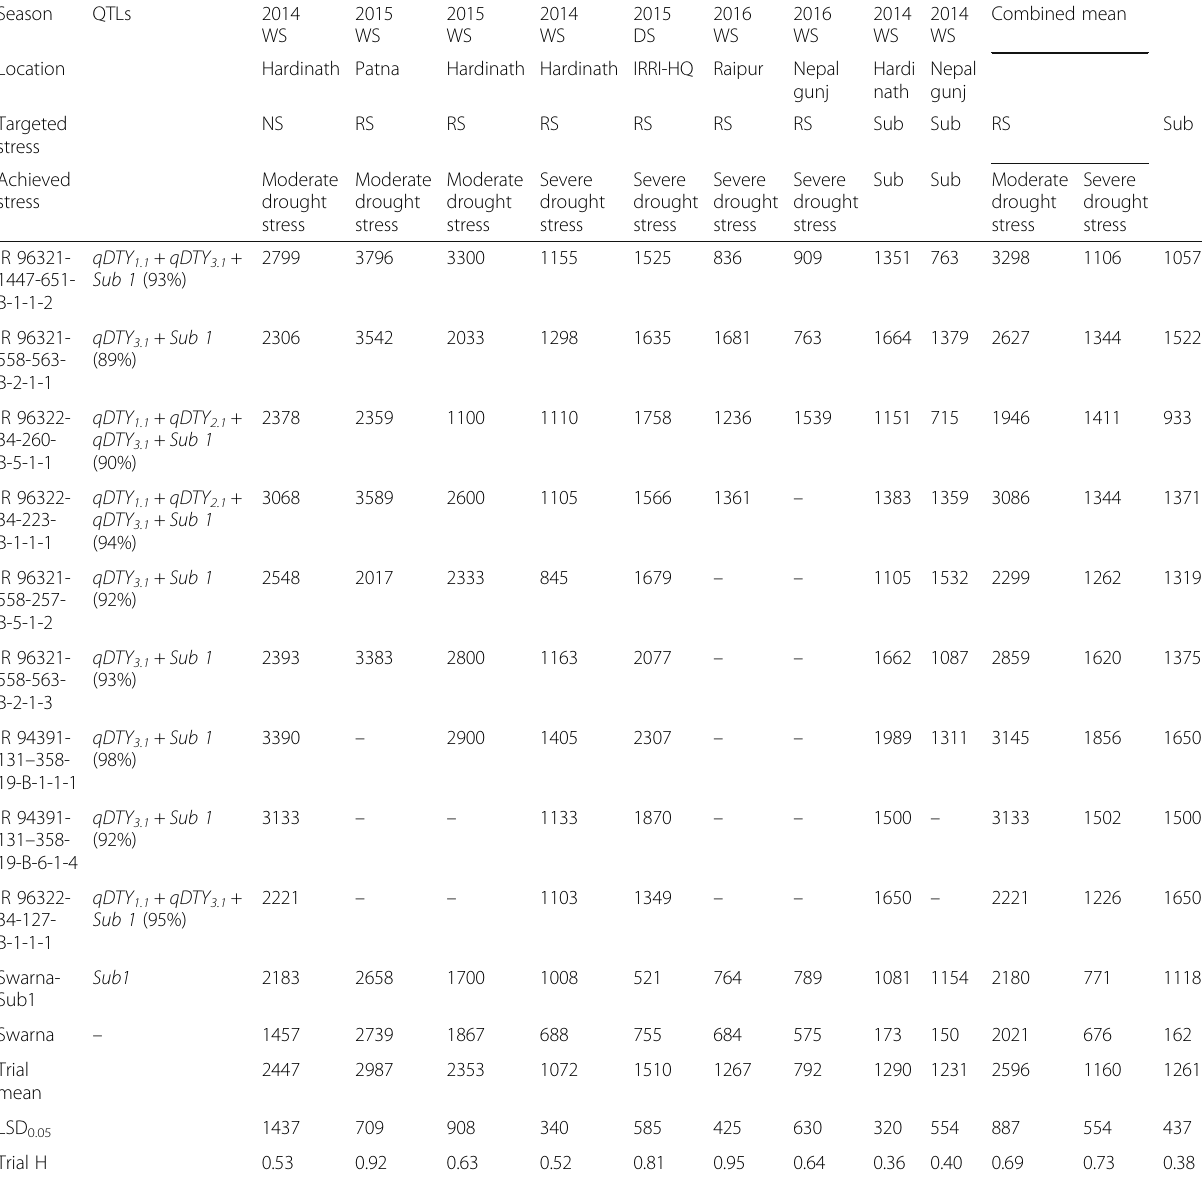
Table 4 The mean grain yield (kg ha − 1 ) performance of selected promising lines across different locations and seasons under moderate and severe reproductive stage drought stress (RS) and submergence conditions (Sub)